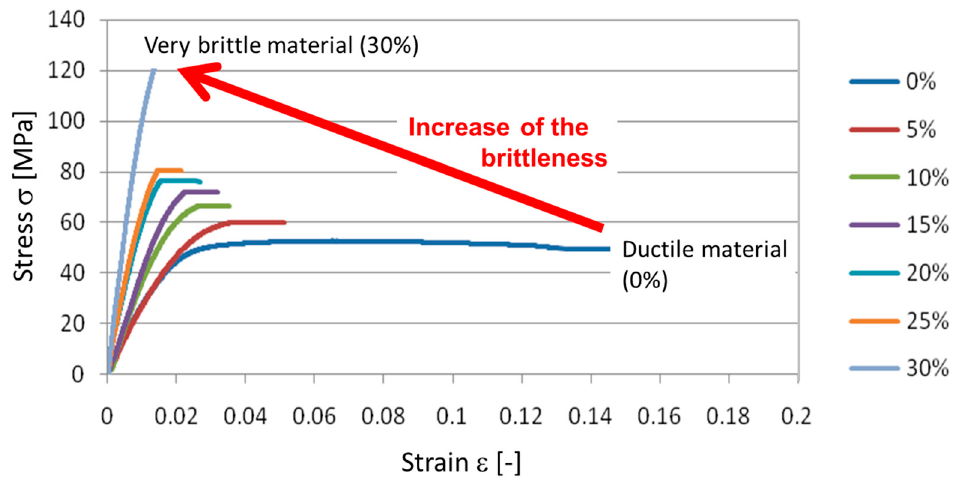
Figure 6. Conventional mean stress–strain diagrams (5 tests/conditions) of the composite materials reinforced with different GF reinforcement rates.